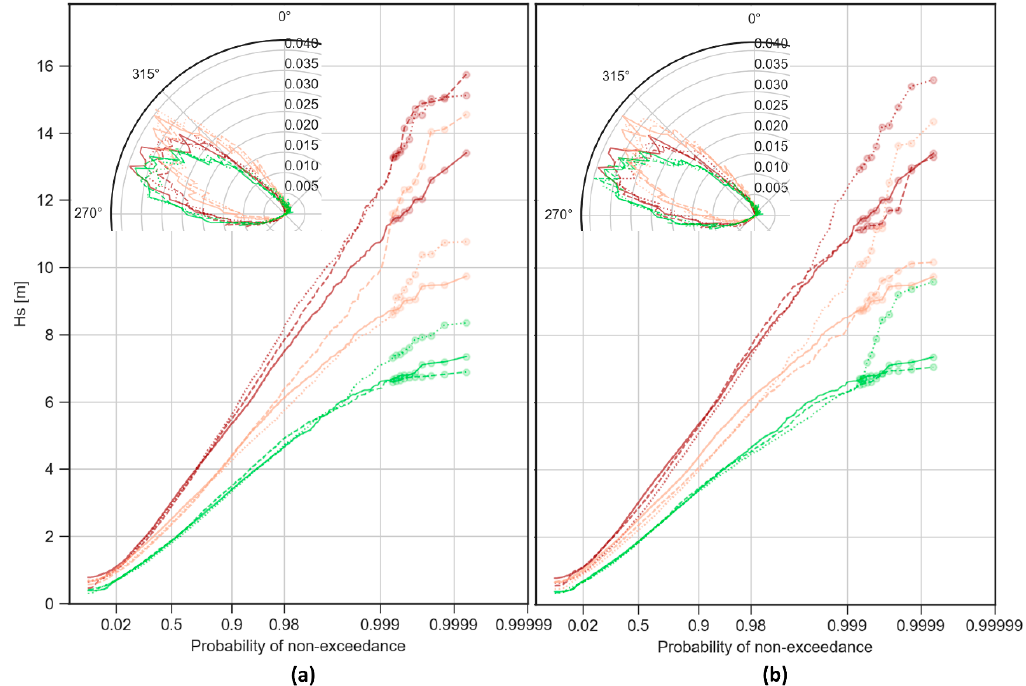
Figure A3. CDFs of the propagated values of H S at deep waters (autumn dataset) with a detail of the polar PDFs of wave directions for: ( a ) Control simulations and short-term simulations (2026–2045) of all models and concentration scenarios; ( b ) Control simulations and long-term simulations (2081–2100) of all models and concentration scenarios.